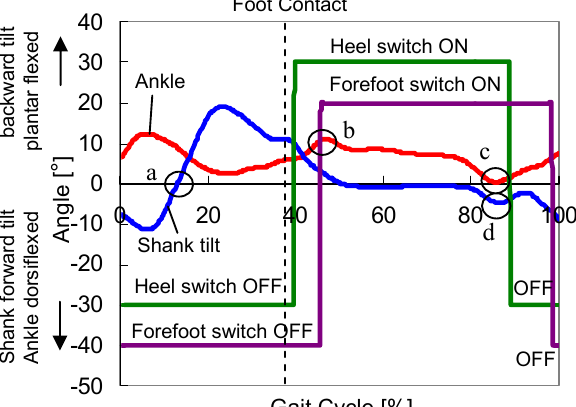
Fig. 4 The shank angle, ankle joint angle, and foot switch state while walking one step beginning from toe